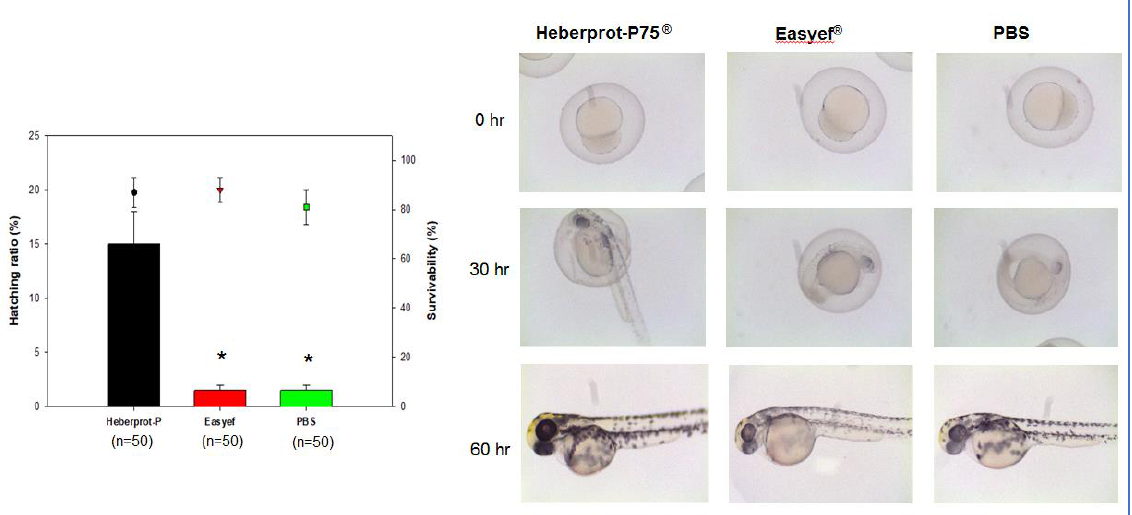
Figure 3. Exposure of Heberprot-P75 ® and Easyef ® (final 0.5 μ g/mL) into water containing zebrafish embryo at 1 hpf. The graph showed the hatching ratio and survivability at 30 h post-exposure. *, p < 0.05 versus Heberprot-P75 ® . The photographs show the stereo image of embryos from each group at 0, 30, and 60 h post-exposure to compare the developmental stage.